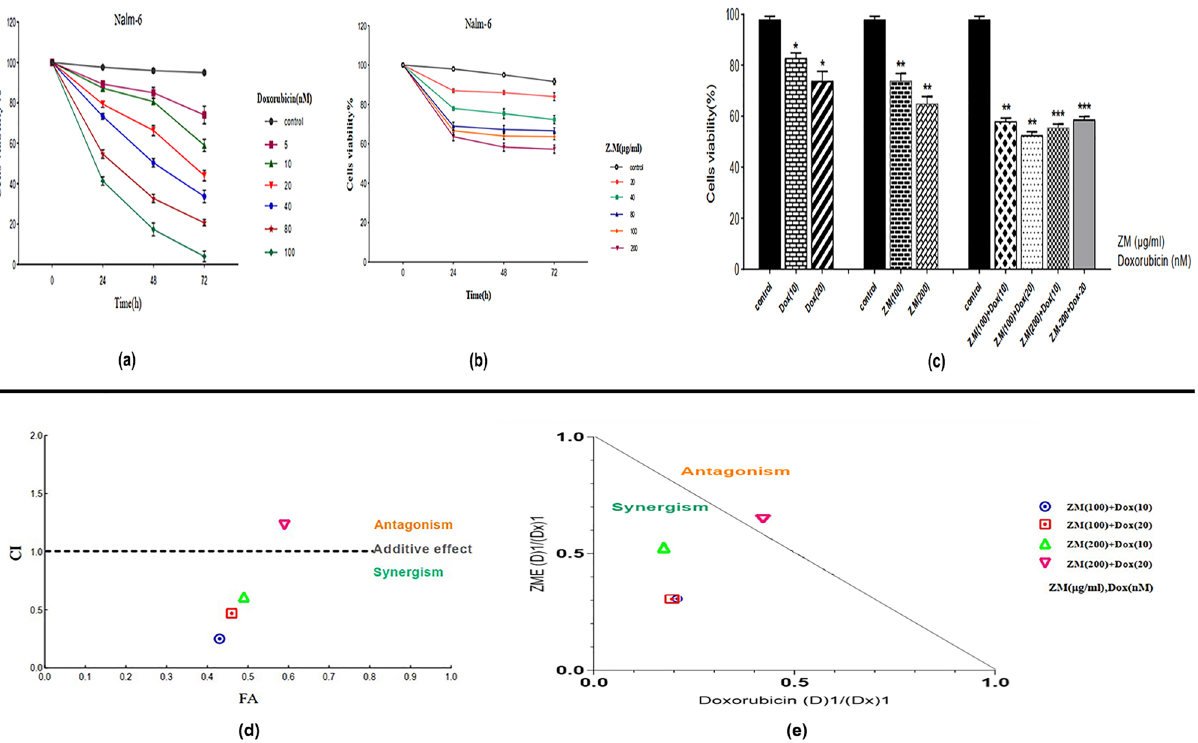
Figure 1. The ZME ( a ) and DOX ( b ) effect of various doses on the viability of Nalm-6 cells using trypan blue assay (mean ± SE, n = 3). These graphs present the changes of ZME and DOX apoptotic effect after 24, 48, 72 h. As shown, different concentrations of ZME and DOX had dose-dependent effect, dose and time- dependent effect, respectively. Effect of ZME and DOX combination and single doses ( c ) after 48 h on the viability of Nalm-6 cells using trypan blue exclusion assay (mean ± SE, n = 3). As shown, combination doses had a more significant apoptotic effect than individual doses on Nalm-6 cells (*P < 0.05, **P < 0.01, ***P < 0.001, relative to untreated cells). The combination index (CI) versus fraction effect (FA) curve ( d ) of ZME and DOX combination treatment. Exposure of Nalm-6 cells with various combinations of ZME and DOX and cell viability values of trypan blue assay was used for CI vs FA. As reported by FA curve, the CI < 1, = 1, and > 1 indicate respectively synergism, additive effect (solid line), and antagonism effect. Combinations of ZME (100 μg/mL) + DOX (10 nM) on Nalm-6 cells demonstrated the most desirable synergism effect among other combinations. Dose-normalized isobologram analysis of ZME and DOX combination. The CI was calculated according to the normalized isobologram equation ( e ). (Dx)1 and (Dx)2 indicate the individual dose of ZME and DOX required to inhibit a given level of viability index, and (D)1 and (D)2 are the doses of ZME and DOX necessary to produce the same effect in combination, respectively. Antagonism effect is represented by above points of the effect line, whereas the points are below the effect line demonstrate the synergism effect. Three combination points for Nalm-6 cells were below the effect line, so showed synergism